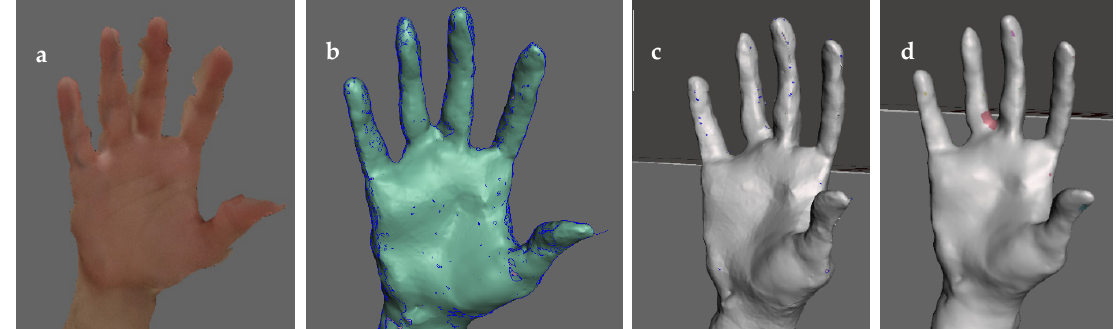
Figure 4. Reconstruction of the hand model in Meshmixer. ( a ) Hand taken from 3DF Zephyr; ( b ) 3D hand model with ring finger and middle finger separated; ( c ) correction of open areas and meshing errors; ( d ) final 3D hand model.